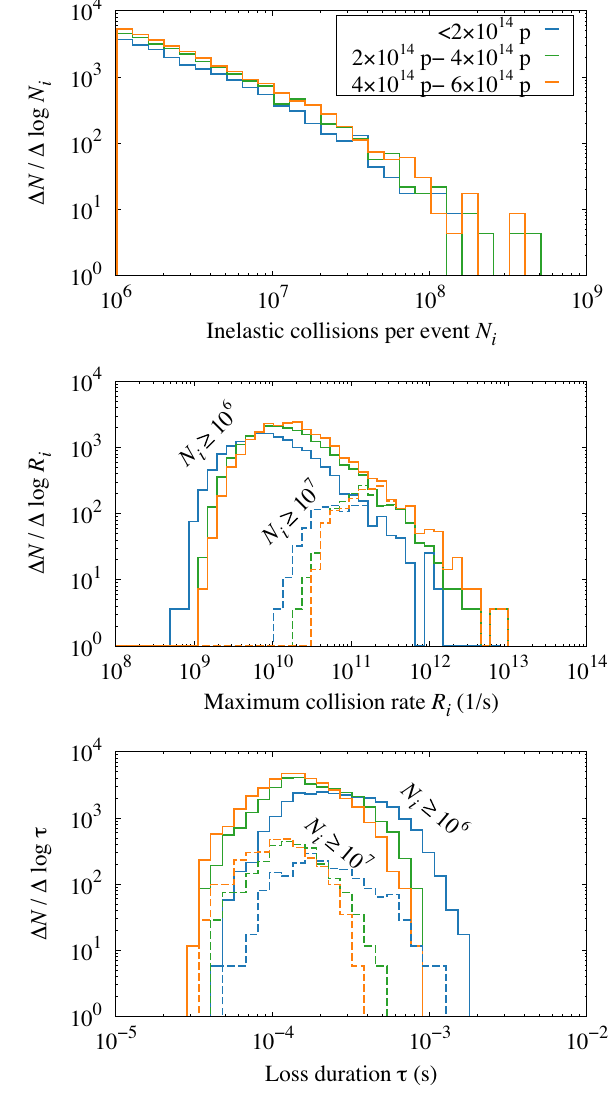
FIG. 14. Simulated distributions of N i , R i and τ for different beam intensity intervals; N indicates the number of events. The different R i and τ distributions correspond to different minimum N i thresholds as indicated in the figures ( grams, N i ≥ 10 7 : dashed